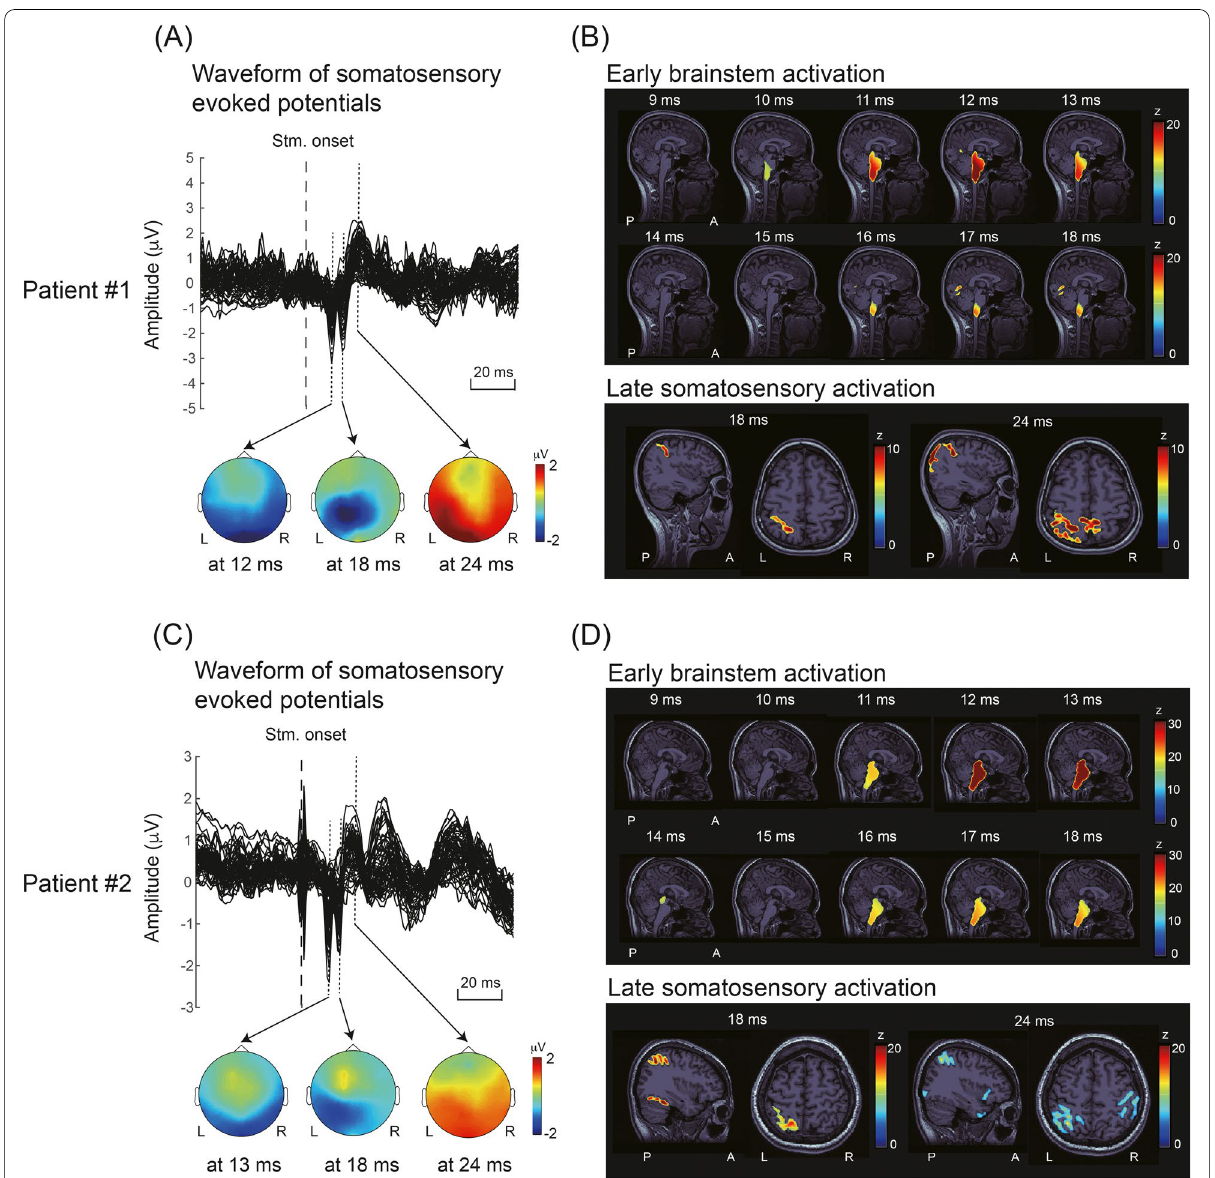
Fig. 2 Representative somatosensory‑evoked responses. A Superimposed SSEPs and corresponding topography at 12, 18, and 24 ms for patient 1. B Early (9–18 ms) and late (18 and 24 ms) activation for patient 1 mapped onto her MRI. C Superimposed SSEPs and corresponding topography at 13, 18, and 24 ms for patient 2. D Early (9–18 ms) and late (18 and 24 ms) activation for patient 2 mapped onto her MRI. Stim., stimulus; L, left; R, right; A, anterior; P,